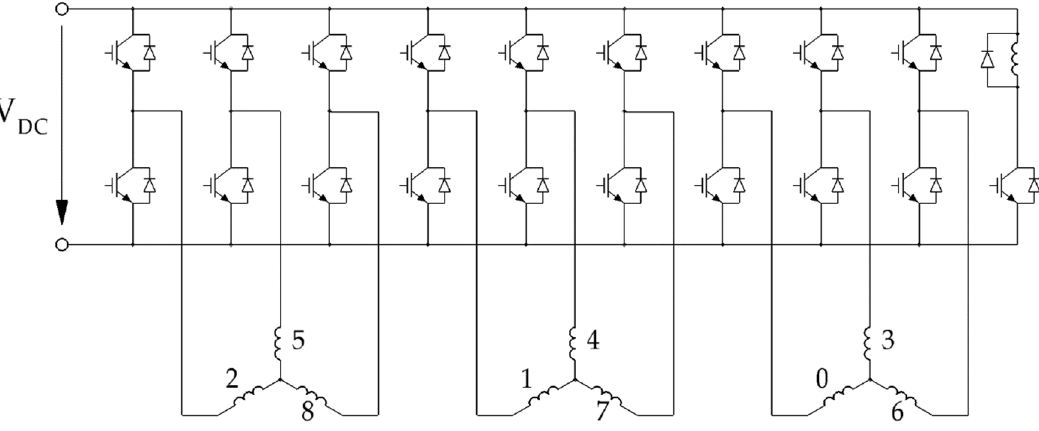
Figure 2. Inverter schematic.